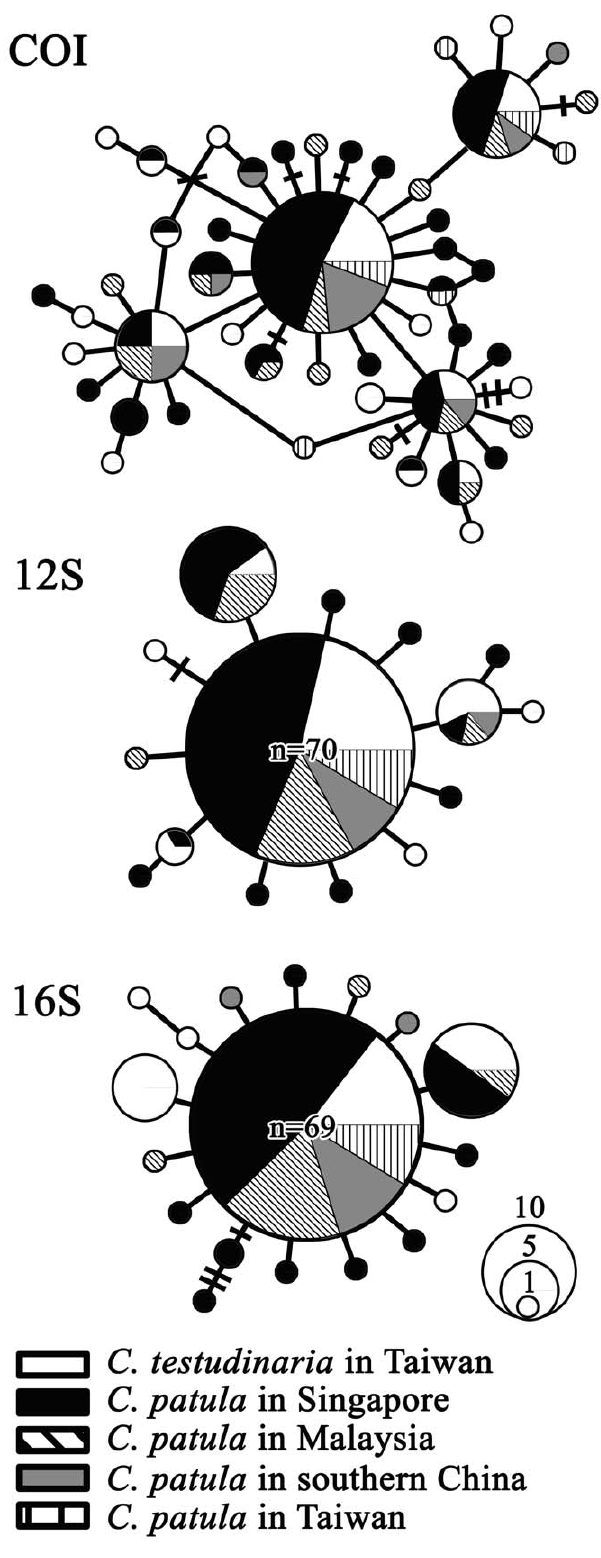
Figure 5. TCS network of Chelonibiatestudinaria (white portion) and C.patula (black and hatched portions) based on mitochon- drial COI, 12S and 16S rRNA markers. Locality of populations of C. patula is indicated in respective black and hatched